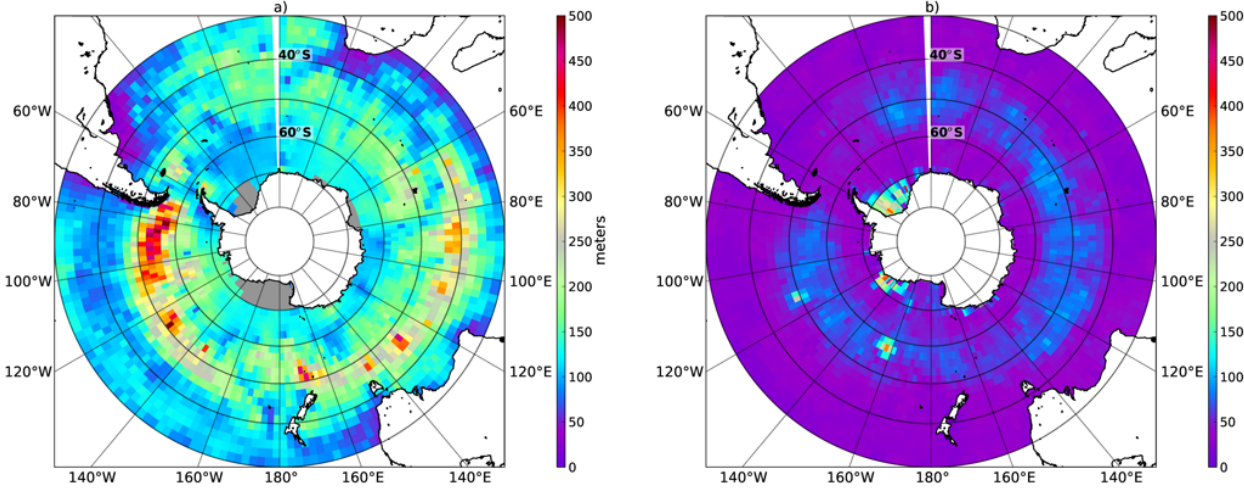
Fig. 6. Average MLD in (a) winter (August) and (b) summer (February) in the Southern Ocean from the De Boyer Mont ´ egut et al. (2004) dataset.